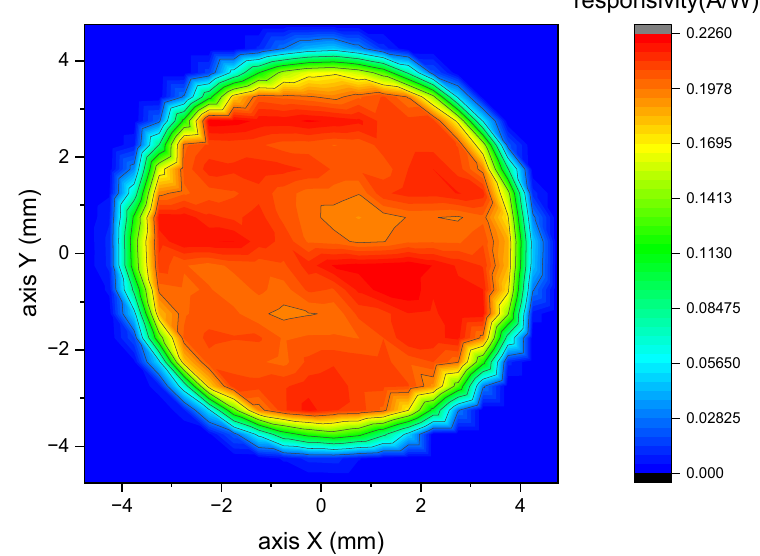
Figure 6. Spatial distribution of the spectral responsivity for the photodiode.